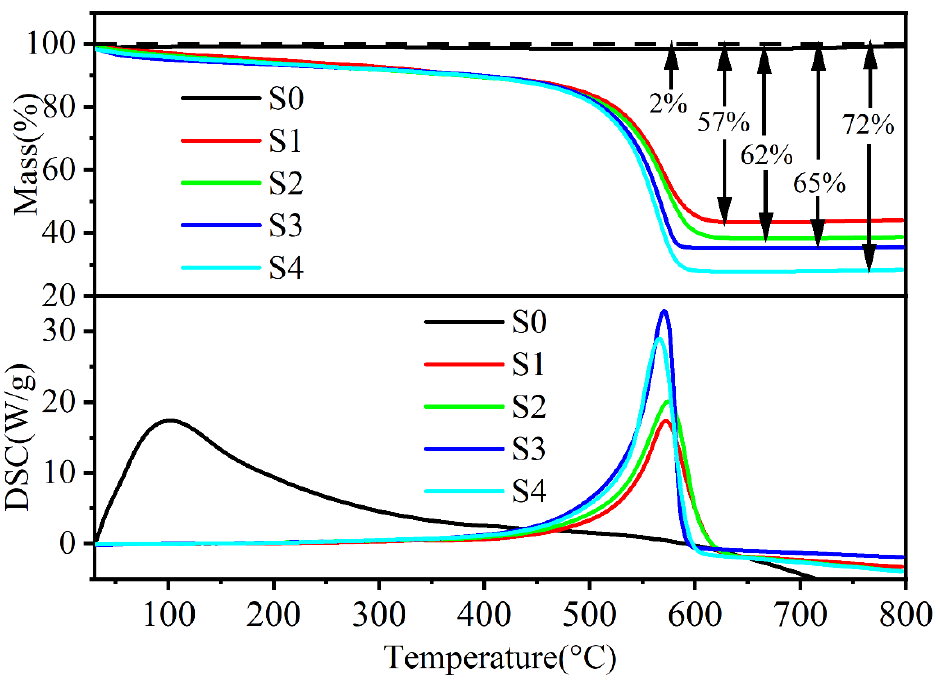
Figure 6. TG − DSC curves of the FeSiAl and FeSiAl@HC S0 − S5 samples; the inset shows the enlarged TG − DSC curves from 30 to 80°C.